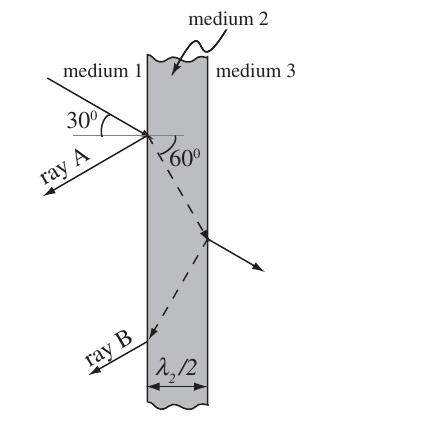
FIG. 2. Diagram shown to students as part of the thin-film interference